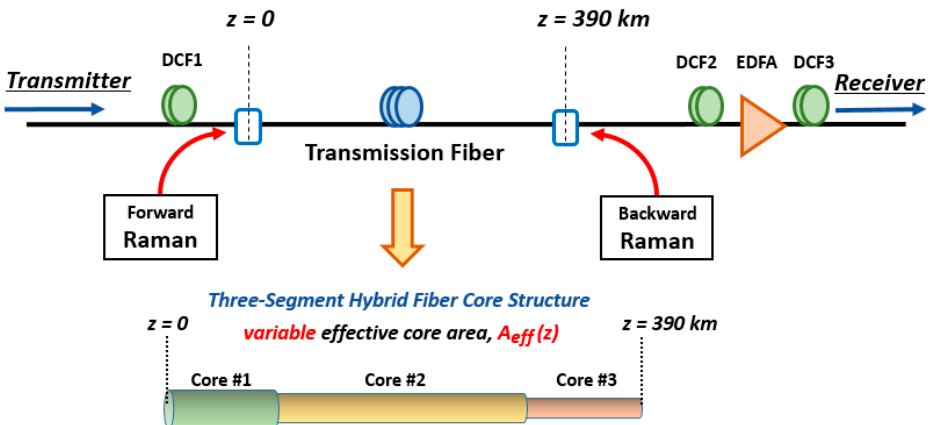
Figure 7. Unrepeatered ultra-long span optical transmission system over 390 km length consisting of a bidirectional distributed Raman amplifier, a three-segment hybrid fiber effective core area, chromatic dispersion compensation fiber (DCF), and erbium-doped fiber amplifier (EDFA). The blue and red arrows indicate the optical signal and Raman pump, respectively.